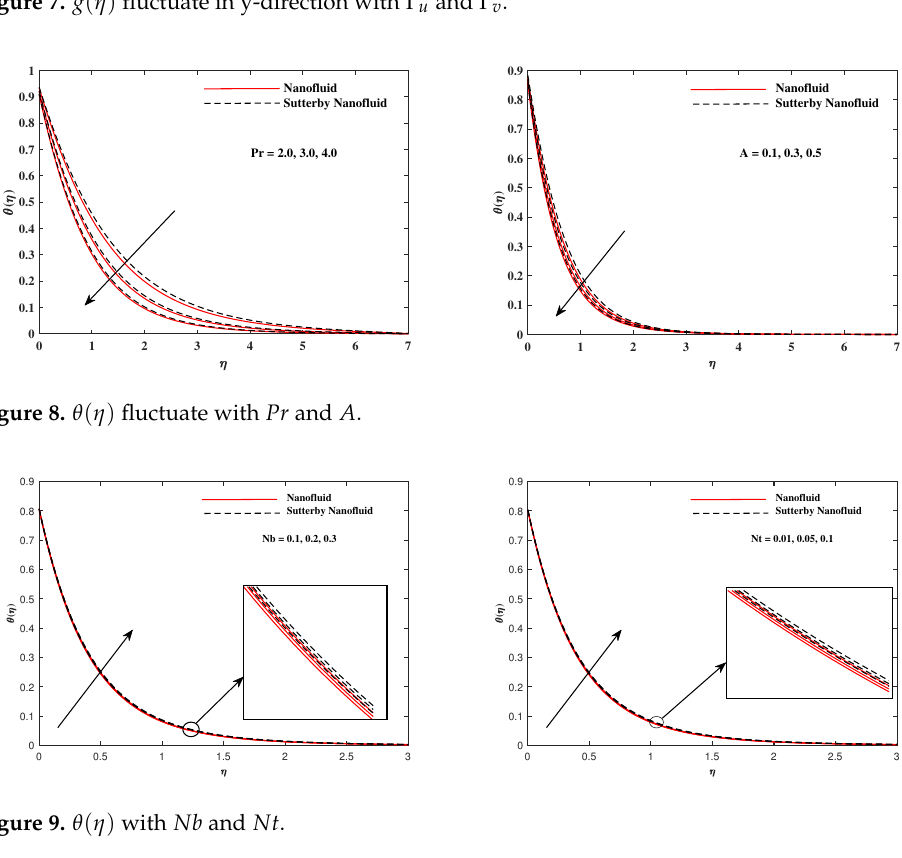
Figure 7. g ( η ) fluctuate in y-direction with Γ u and Γ v .